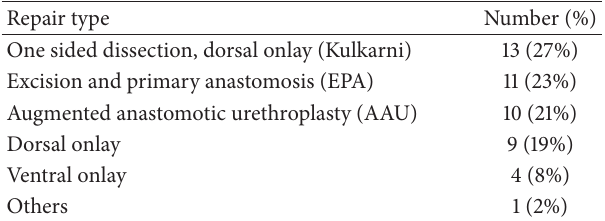
Table 2: Type of